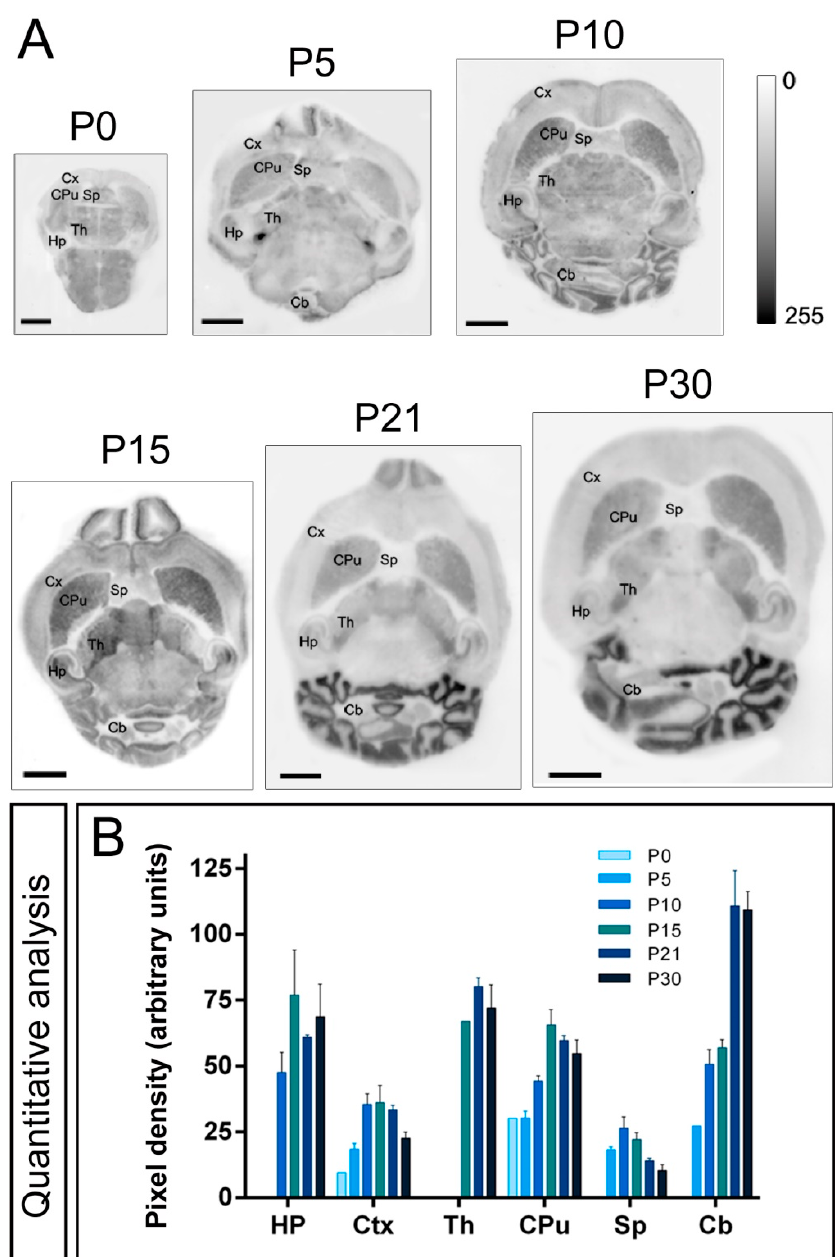
Figure 3. Developmental and regional distribution of the Kv4.2 channel in the mouse brain. ( A ) Kv4.2 protein distribution was visualised on histoblots of brain horizontal sections at various stages of postnatal development using an affinity-purified anti-Kv4.2 antibody. Kv4.2 was expressed in the brain since the day of birth (P0), and at all stages the strongest expression was detected in the cerebellum (Cb), caudate putamen (CPu), hippocampus (Hp) and thalamus (Th), with the lowest intensity in the cortex (Cx) and septum (Sp); ( B ) The histoblots were scanned and densitometric measurements from four independent experiments were averaged to compare the protein densities for each developmental time point. The analysis revealed a differential Kv4.2 expression in a developmental stage- and region-specific manner. Kv4.2 expression was detected at P0, increased progressively to reach a peak at P10, P15 or P21 depending on the brain region, and then decreasing at P30. Error bars indicate SEM. Scale bars, 2 mm.